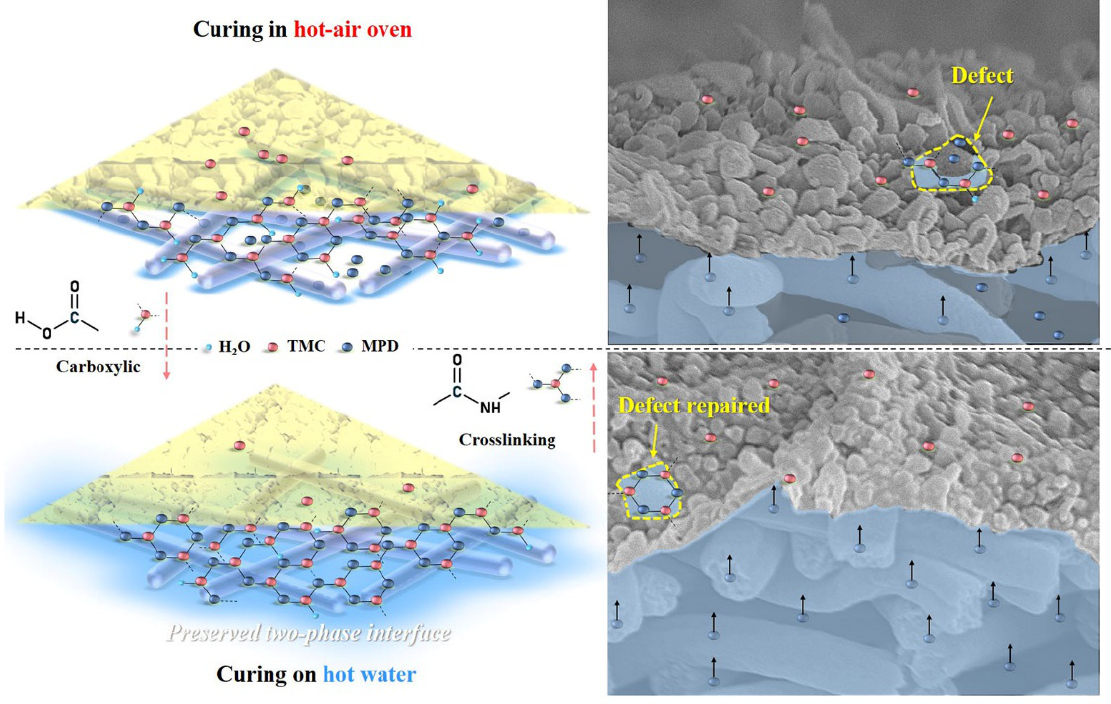
Figure 11. Schematic diagram of the formation process of nanofiber-supported PA-TFC FO membranes with oven-curing and hot-water-curing.